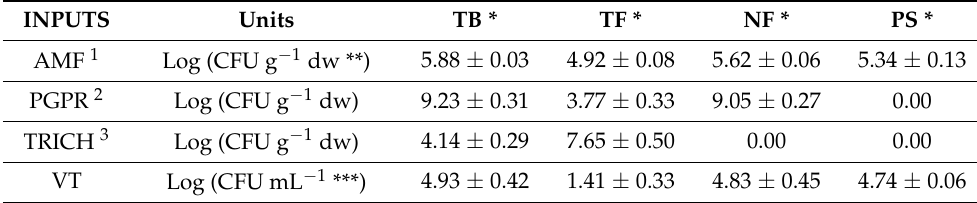
Table 4. Initial mean values of total microbial load (bacteria and total fungi) and functional groups of the microbiota provided by each PGPMs consortium (AMF, PGPR, and TRICH) and vermicompost tea used as an organic nutrient solution in fertigation (VT) evaluated in this research study. INPUTS Units TB * TF * NF * PS * AMF 1 Log (CFU g − 1 dw **) 5.88 ± 0.03 PGPR 2 Log (CFU g − 1 dw) TRICH 3 Log (CFU g − 1 dw) VT Log (CFU mL − 1